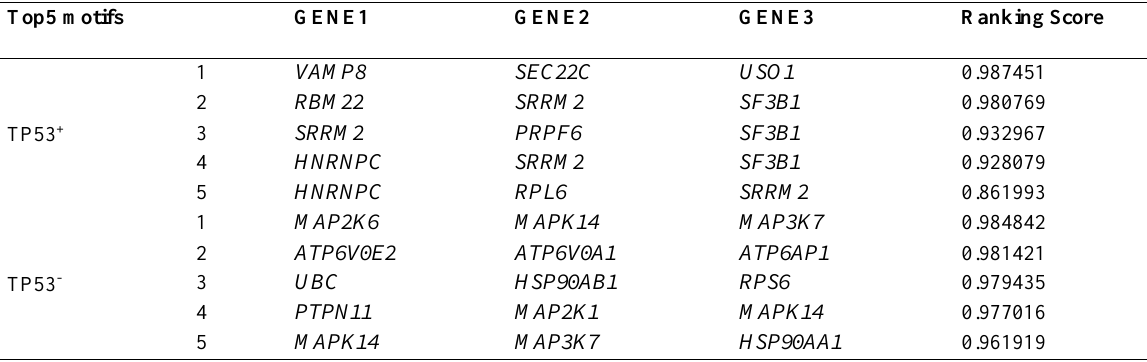
Table 3. Five top-ranked motifs for subtypes TP53 + and TP53 - . Top5